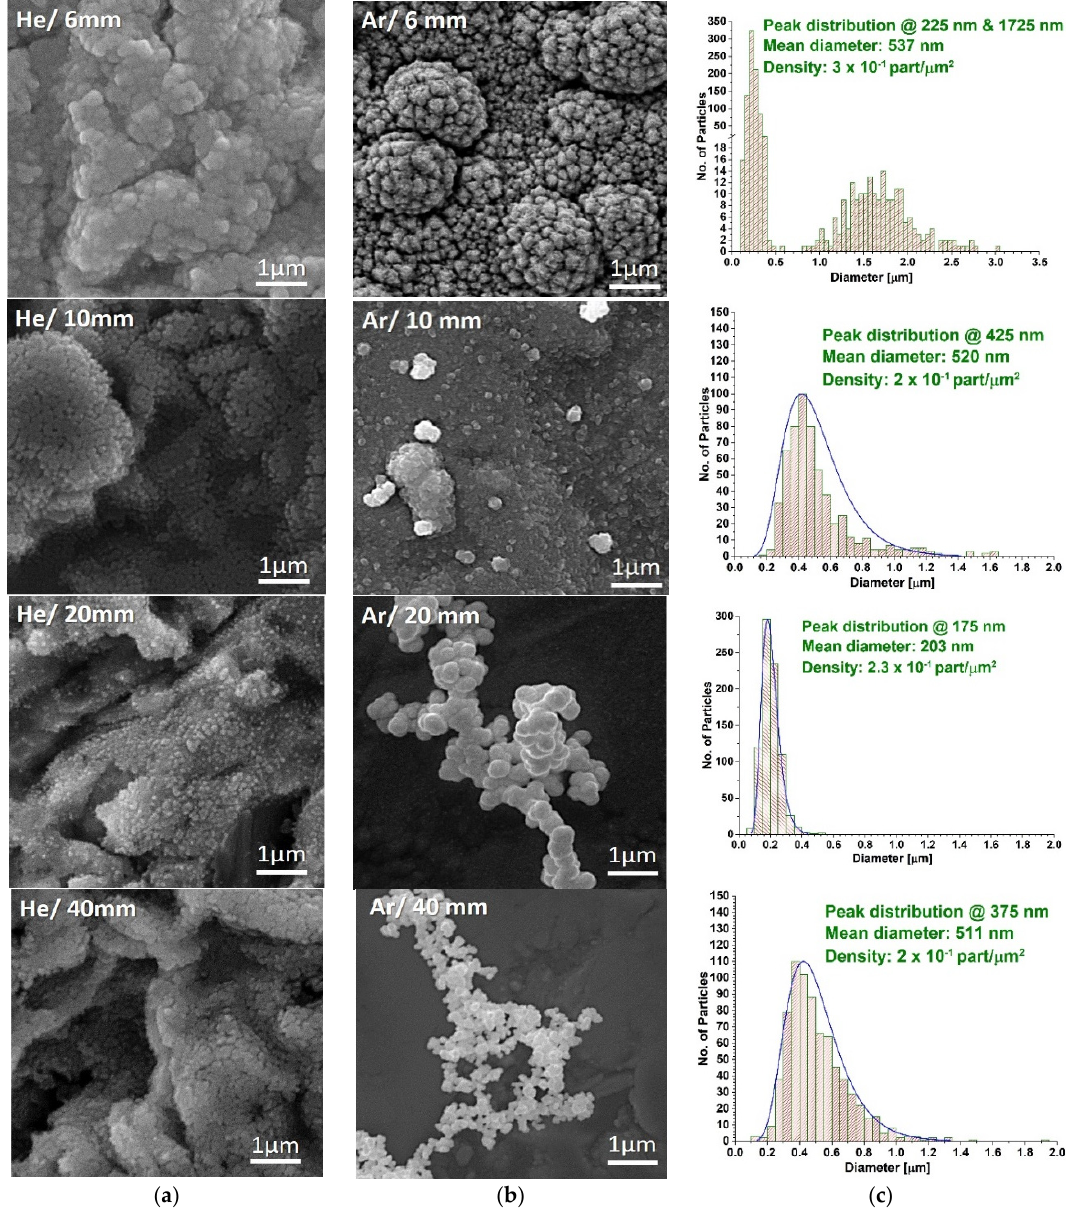
Figure 5. SEM images of W dust obtained in Hollow-Cathode discharge: ( a ) He discharge; ( b ) Ar discharge; and ( c ) Particles size distributions for Ar discharge.